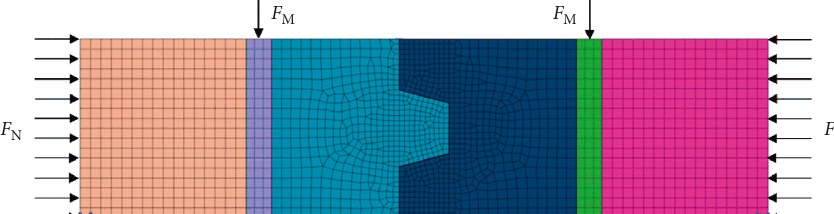
Figure 10: Loading and boundary conditions of the numerical model.